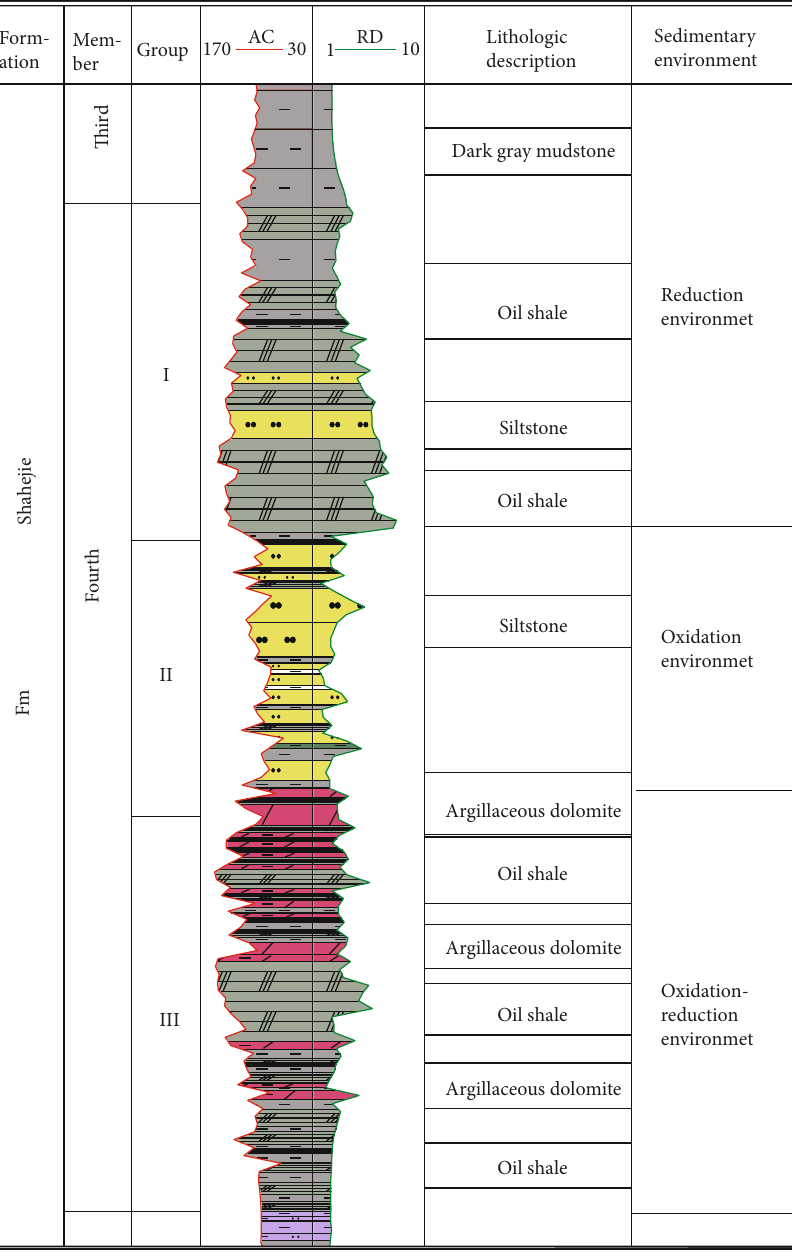
s 4L submember of the study 2